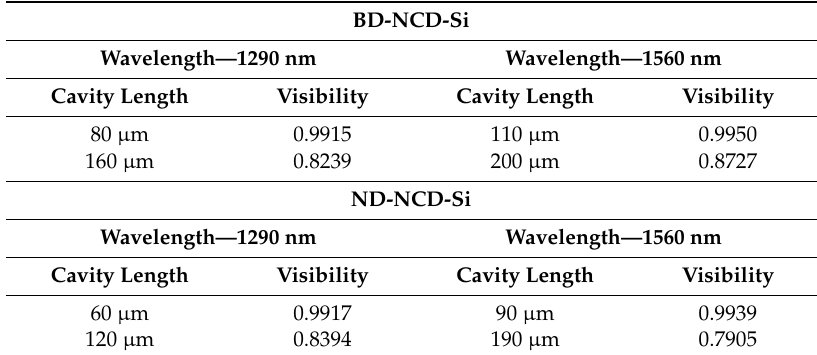
Table 1. Visibility values calculated for representative cavity lengths filled with air measured on